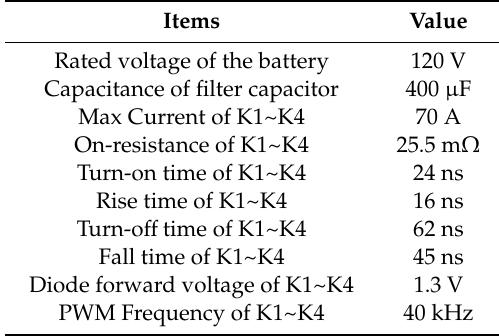
Table 2. Parameters of the designed pulse-width modulation (PWM) rectifier. Items